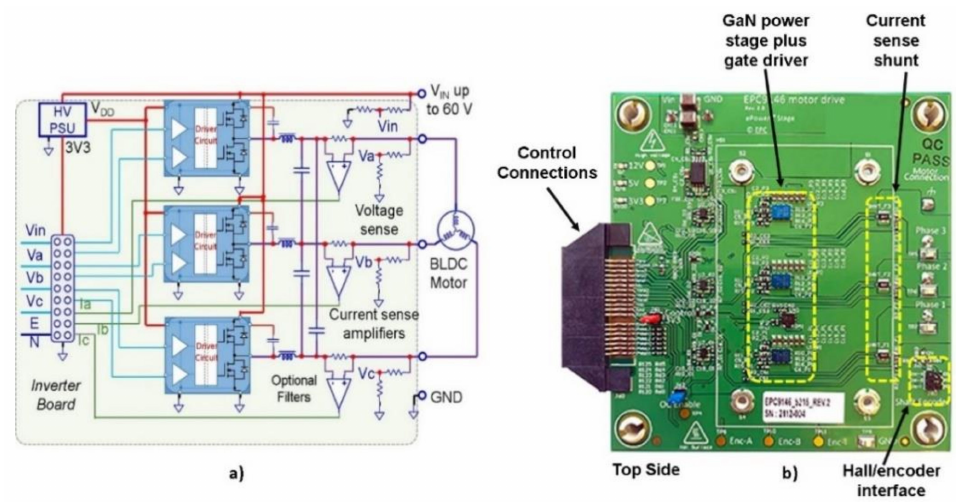
Figure 6. ( a ) Inverter board schematic. ( b ) Photo of the top side of the inverter board. The second inverter experimental board is based on GaN FETs 80 V of breakdown voltage and a R DS,on equal to 1.8 m Ω (EPC2206). The switches in every bridge leg are based on two discrete GaN FET featuring a 6.1 × 2.3 mm package. The supply voltage is 48 V (the board was designed for a DC link voltage up to 60 V). The output phase current nominal was 15A rms . In the experimental board, there are two kinds of current sensing networks, source, and phase, and the user can decide which to use. Every bridge leg in the source path of a lower GaN FET has a sensing resistor R S to measure the switching leg current, and to monitor the overcurrent to activate the protection circuit. The same signal can also be measured in phase through a phase current resistor R SL . The maximum power is rated up to 1.5 kW. The general schematic of a battery powered inverter for PM sinusoidal drive with two the sensing current network is shown in Figure 7a. A picture of the inverter board top side is shown in Figure 7b with a zoomed view of a bridge leg arrangement and phase resistor.